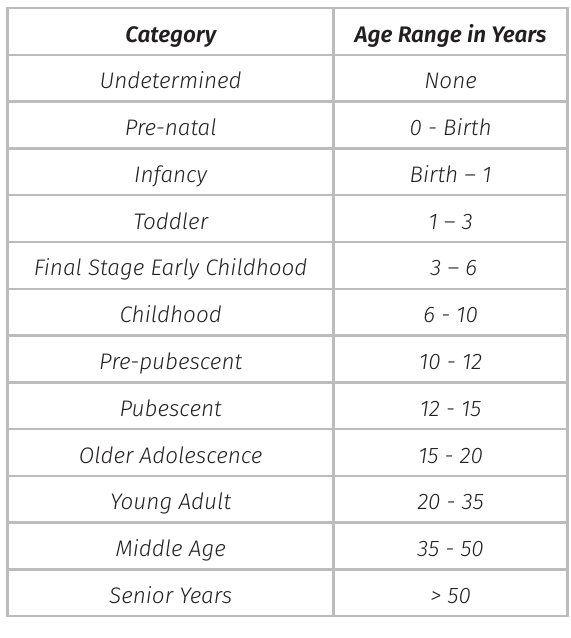
Table IV. Age at Death categorization (categories established according to anthropologic methods and biological maturation data from Buikstra & Ubelaker (1994), Baker et al. (2005) and Schaefer et al.